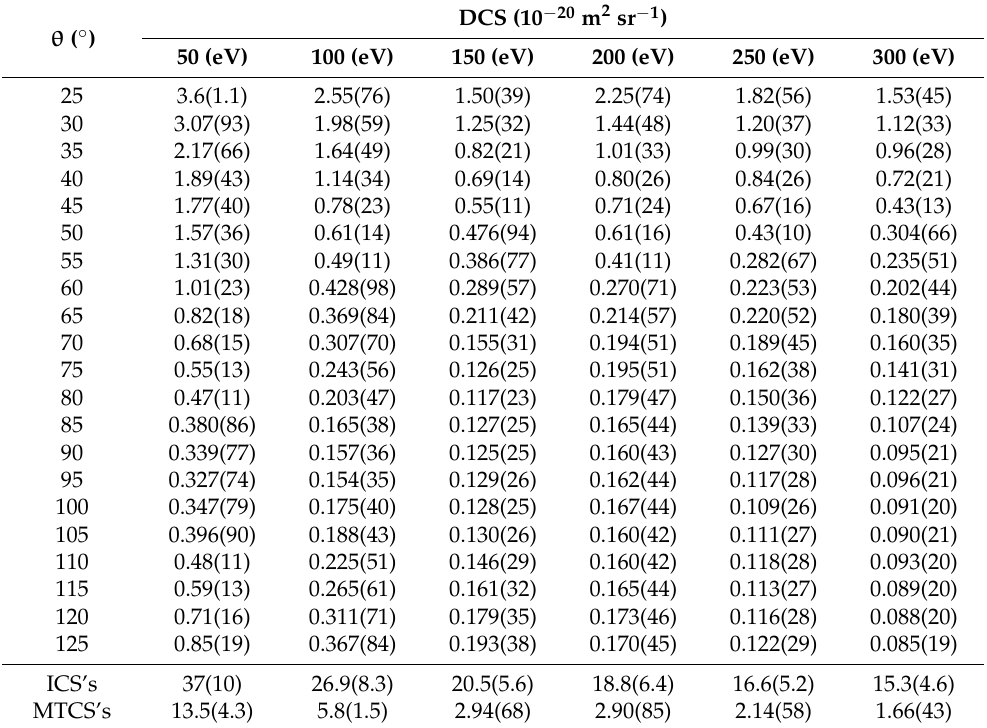
Table 1. Experimental results for absolute differential cross-sections (DCSs), integral cross-sections (ICSs) and momentum transfer cross-sections (MTCSs) for elastic electron scattering from sevoflurane. In parentheses are given absolute uncertainties of the last two